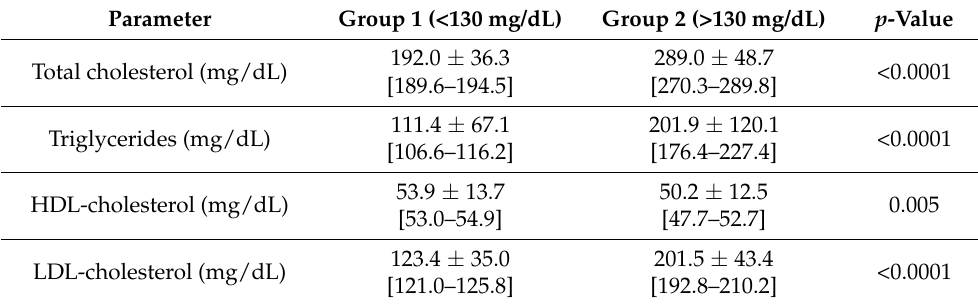
Table 2. Lipid profile in low versus high Apo B groups.